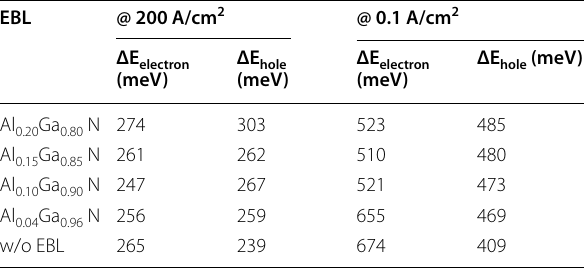
Table 1 Effective energy barrier height of different EBL structures for electrons and holes at 200 and 0.1 A/cm 2 ,